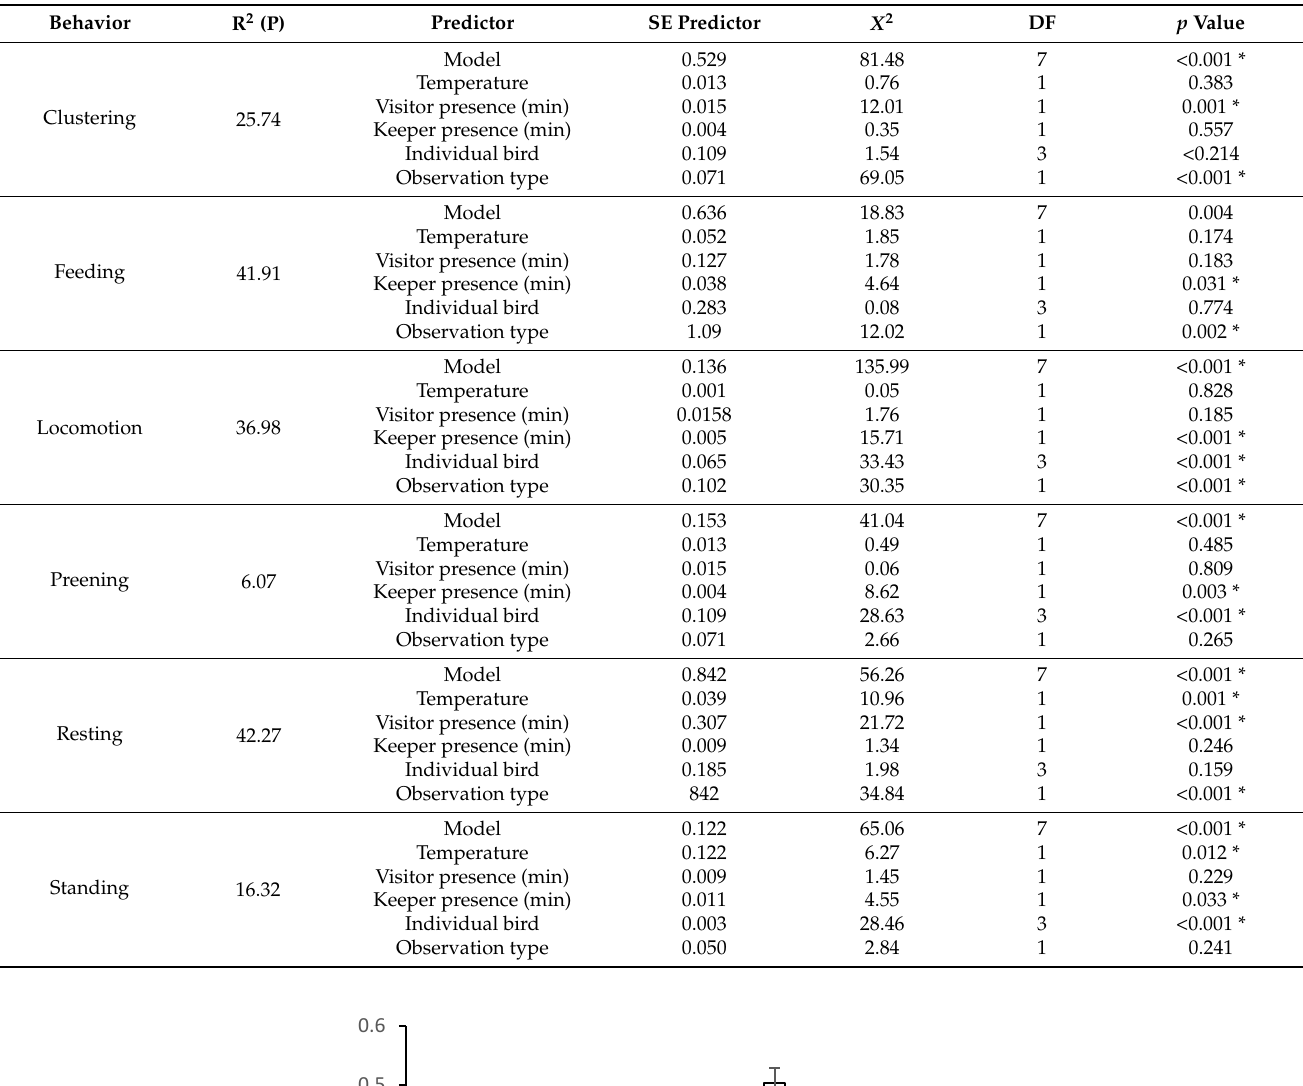
Table 3. Output of Poisson regressions for Edwards’ pheasant state behavior. * indicates a significant value.